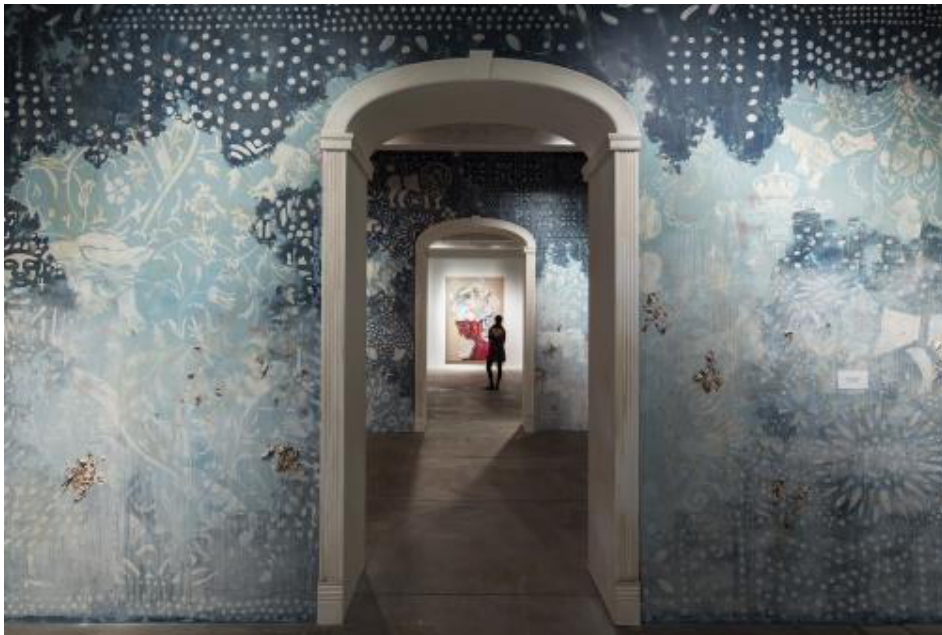
Installation view of Firelei Báez: Bloodlines with Sans-Souci (this threshold between a dematerialized and a historicized body) (2015, acrylic and ink on linen, 74 x 108 in.) as seen through the arches of the mural walls. The Andy Warhol Museum, Pittsburgh, photograph by Abby Warhola,